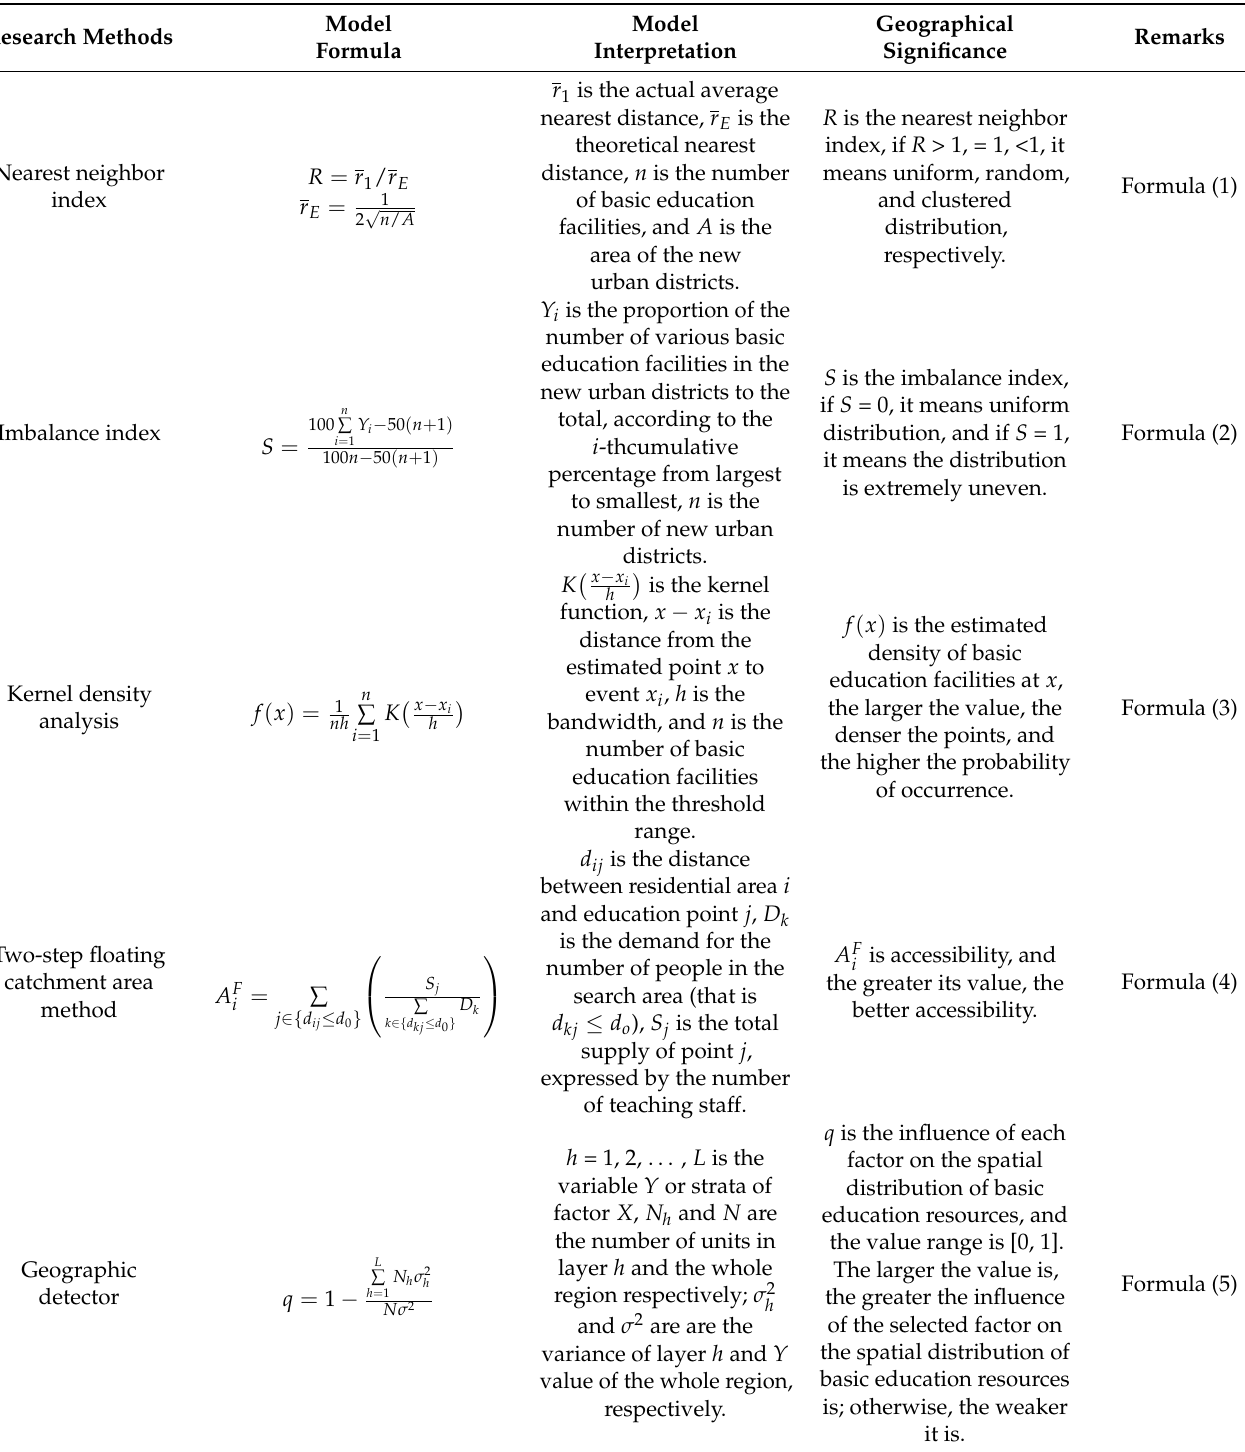
Table 1. Interpretation of basic geographic analysis